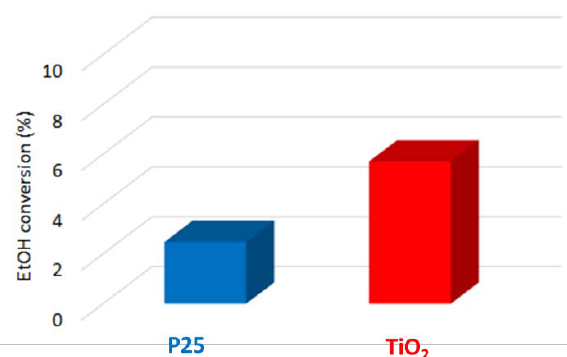
Figure 1. Ethanol conversion of P25 and TiO 2 .